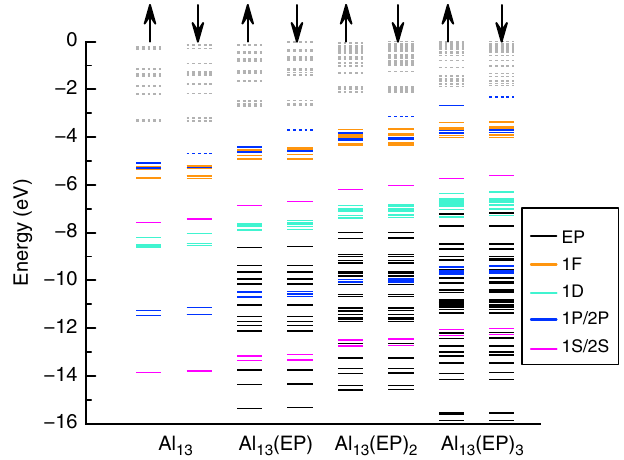
Fig. 8 One-electron energy levels of Al 13 (EP) n ( n = 0 – 3) clusters. The occupied and unoccupied states are represented by solid and dashed